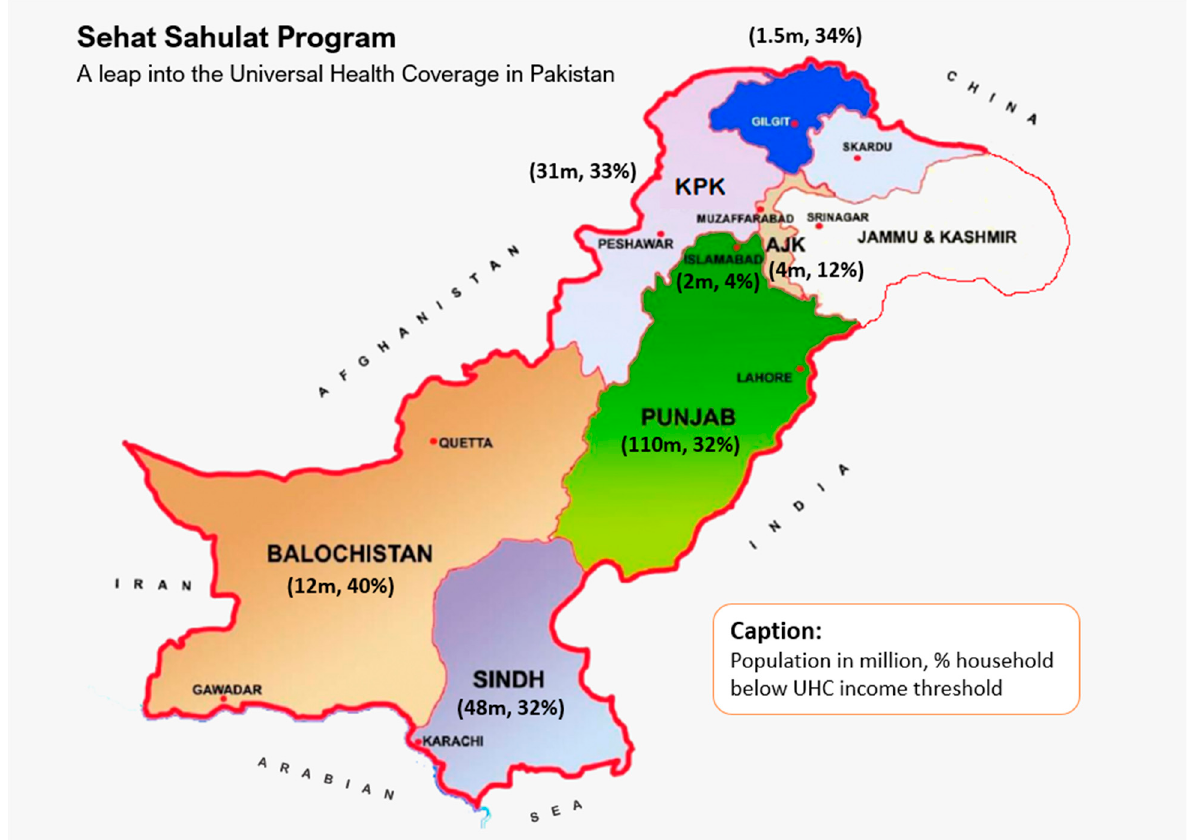
Figure 1. Geographical map of Pakistan showing four major provinces (Sindh, Baluchistan, Khyber Pakhtunkhwa, Punjab), Islamabad Capital territory, and autonomous territories under Pakistan administration (Gilgit Baltistan and Azad and Jammu Kashmir) with population in millions (2017 Census) and percentage of population below UHC income threshold (NSER—Pakistan’s national socioeconomic registry) in each province/territory.